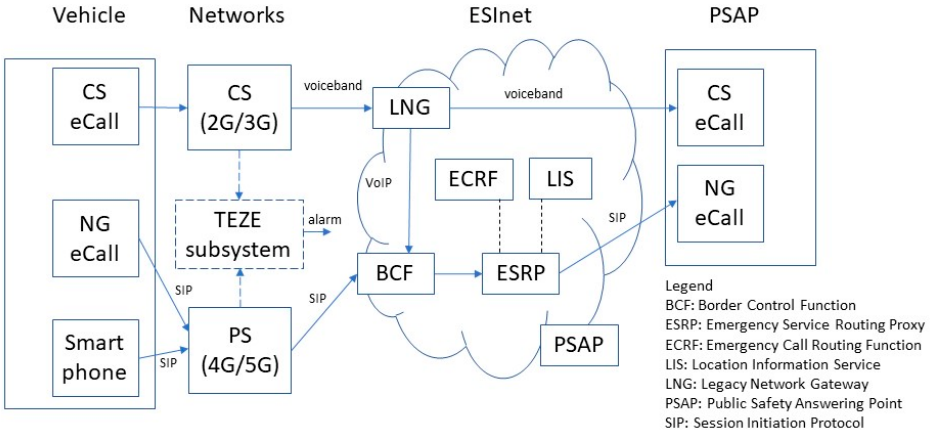
Figure 2. Co-existence of NG eCall and CS eCall.